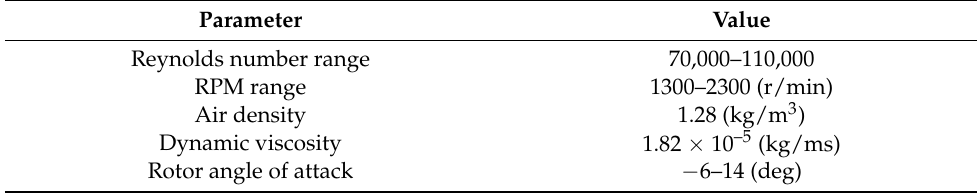
Table 2. Specific parameters of the